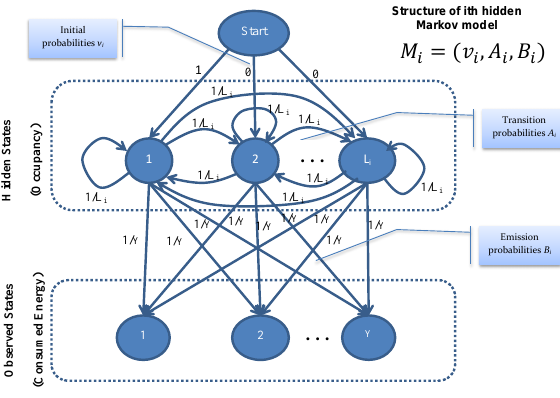
Figure 2. Hidden Markov Model components and internal structure after initialization (before